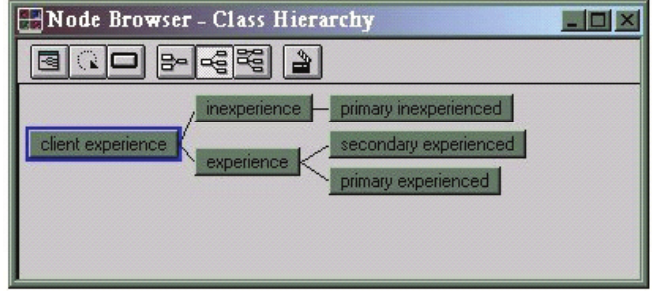
Figure 5: Possible values for the attribute of “client experience”